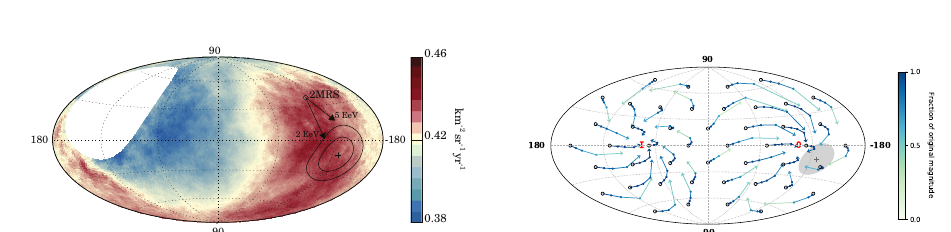
Figure 3. Measured CR flux for E > 8 EeV, averaged on top-hat windows of 45 ◦ , in Galactic coordinates (left panel) [4]. The direction of the reconstructed dipole direction is shown, together with the ellipses corresponding to the 68% and 95% CL regions. The right panel shows the changes in direction and amplitude of a dipolar extragalactic distribution after crossing the Galactic magnetic field, with circles being the original direction and the di ff erent points along the arrow corresponding to E / Z = 32 EeV, 16 EeV, 8 EeV and 4 EeV